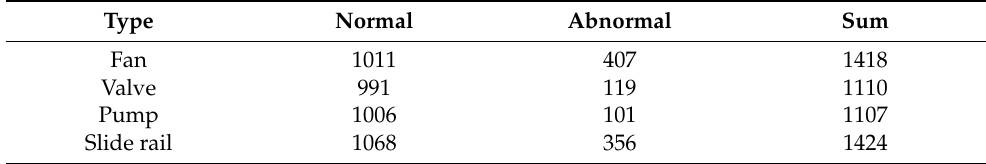
Table 1. Number of MIMII dataset recordings used.